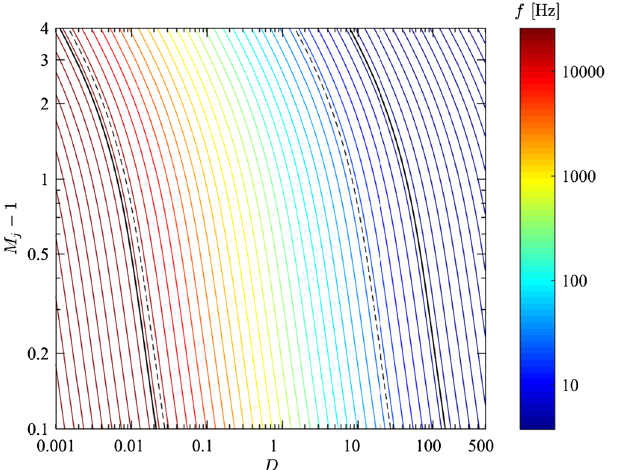
Figure 1. Peak frequency of the broadband shock noise (BBSN) radiated by a jet with different Mach numbers (M j ) and diameters (D) for γ = 1.67 and a reservoir to unbounded chamber temperature ratio T r /T ∞ = 1. The color-scale ranges from 3.75 to 20 000 Hz, the same frequency range as our microphone. This frequency range is also represented in the diagram with two solid black lines. The two dashed black lines correspond to the average human hearing frequency range (20–17 000